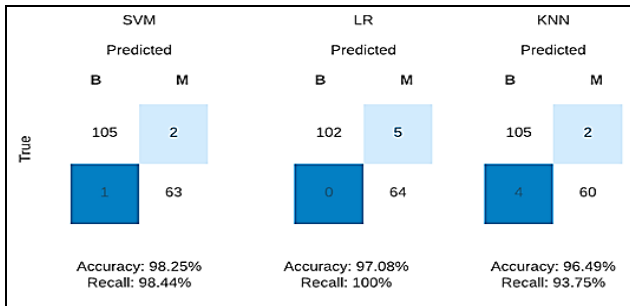
Figure 4. Confusion matrix outcomes of three models with selective features